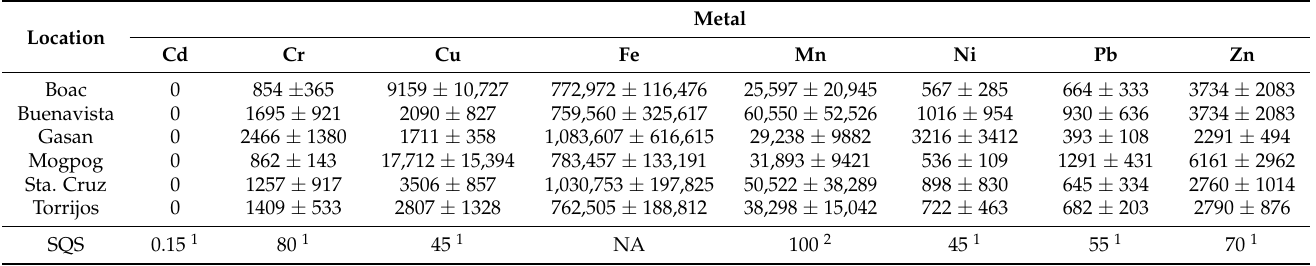
Table 2. Mean concentrations of metals in soil (mg kg − 1 ) with soil quality standards (SQS), n = 90. Metal